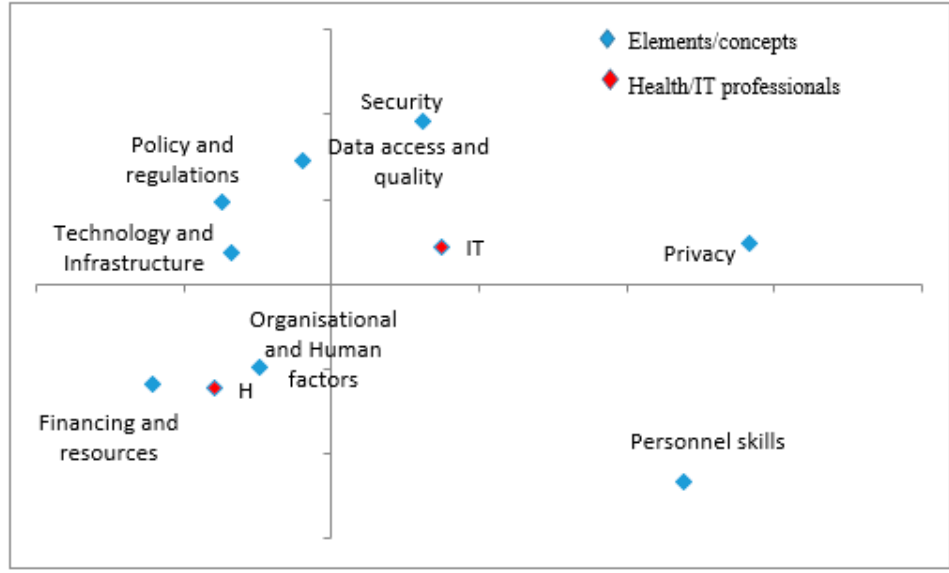
Figure 5. Challenges of Big